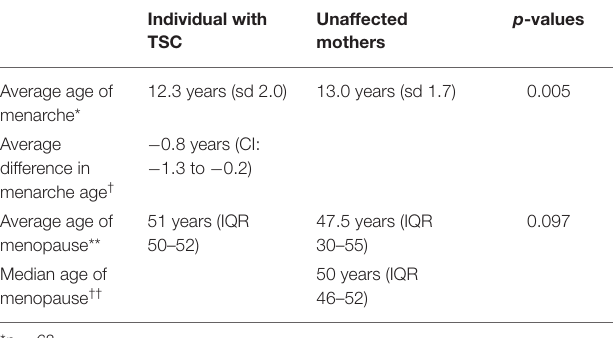
TABLE 2 | Comparison between respondents and maternal data. Individual with TSC